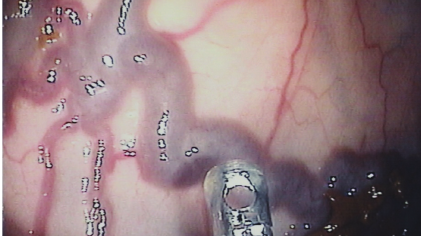
Figure 4: Large, torturous vessel at ileocolonic anastomosis. To demonstrate the size of the vessel. the tip of the forceps is used as a 2.8 mm reference size.